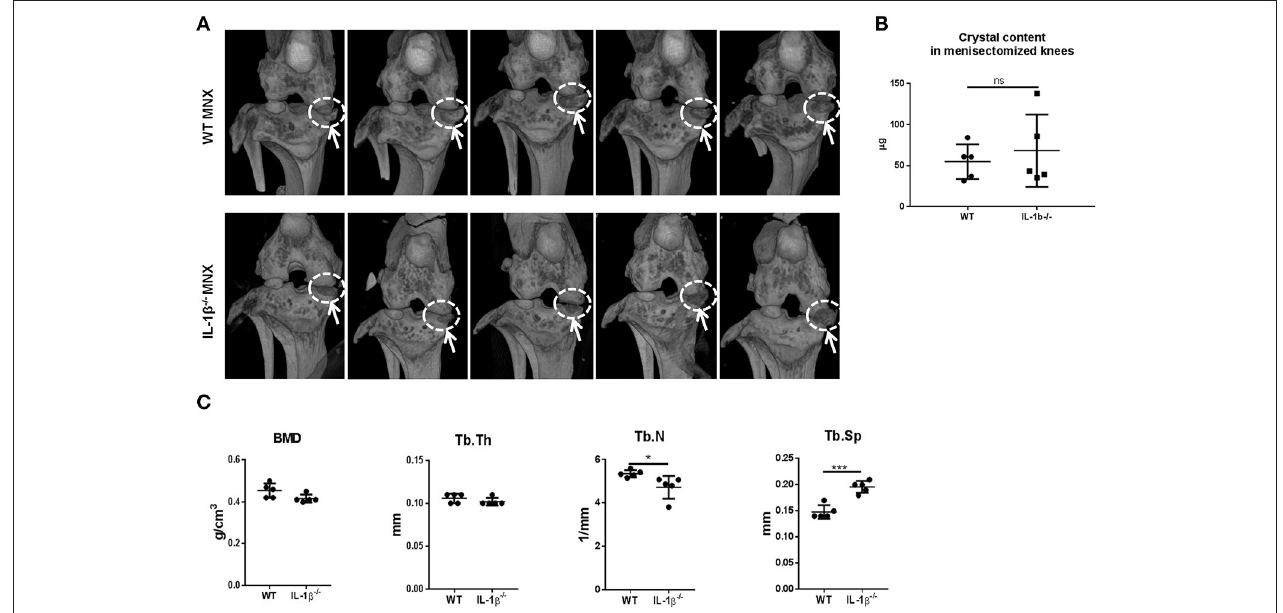
FIGURE 3 | Calcific deposits and tibial subchondral trabecular bone parameters in osteoarthritic knee joints of WT and IL-1 β − / − mice. (A) Micro-CT scan images of menisectomized murine knee joints 2 months after surgery. White circles show new periarticular crystal deposits in menisectomized knees. (B) Crystal content in the menisectomized knees and (C) tibial subchondral trabecular bone parameters were measured in the same animals using CTAnalyzer. Mice number: WT n = 5, IL-1 β − / − n = 5. * p < 0.05; *** p <